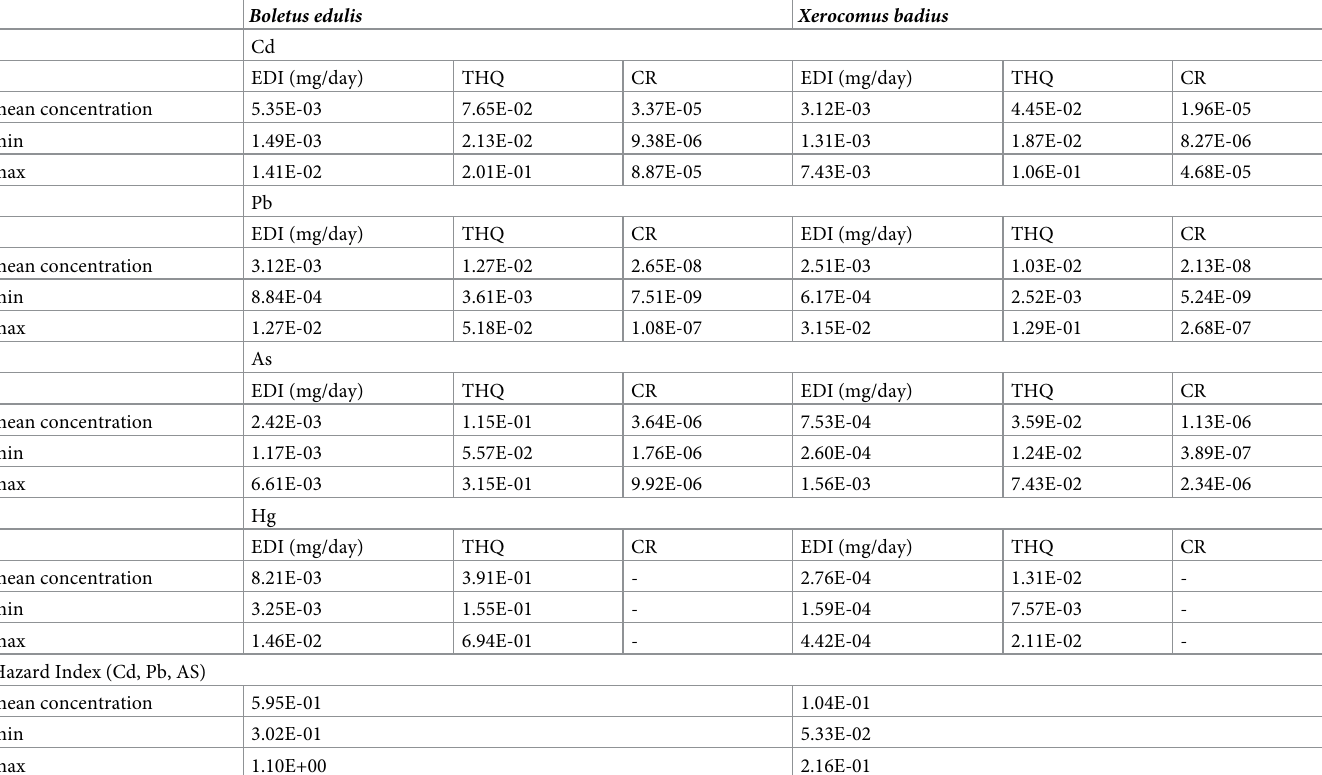
Table 4. Estimated Daily Intake (EDI), Target Hazard Quotient (THQ), Carcinogenic Risk (CR) and Hazard Index for Cd, Pb, As and Hg, resulting from the con- sumption of dried mushrooms by a person with an average body weight of 70